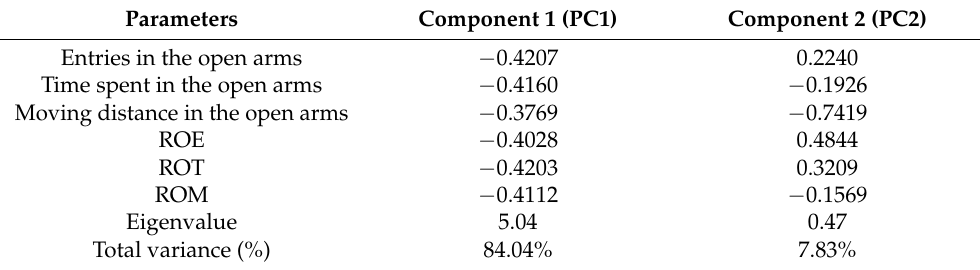
Table 1. Eigenvalues and eigenvectors of the first two components (PC1 and PC2), showing the percentage of